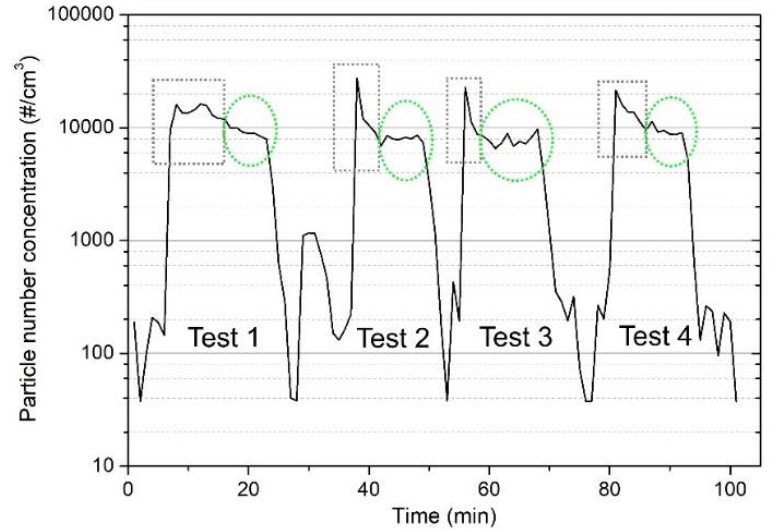
Figure 6. Total particle number concentration as measured by MiniWRAS instrument for the four repetitions. Grey rectangles indicate running-in period and green ellipses indicate steady state.